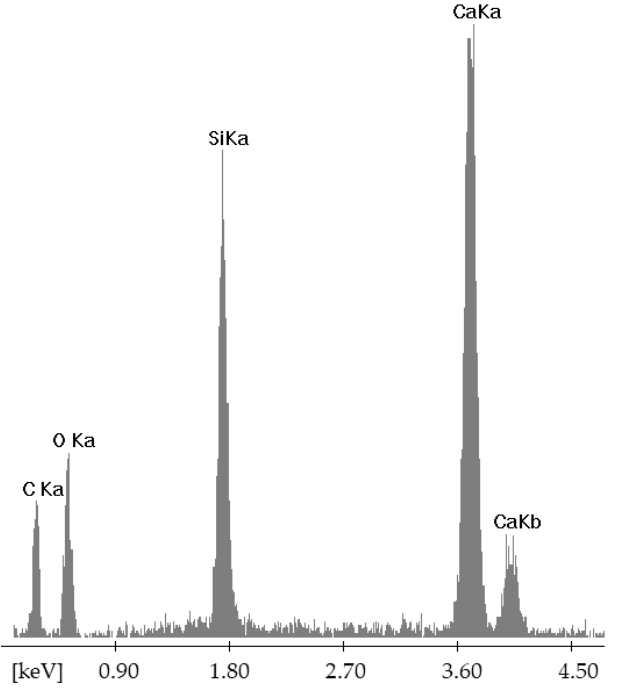
Figure 16. EDS spectrum for traditional sand-lime bricks (containing quartz sand): Point 2.